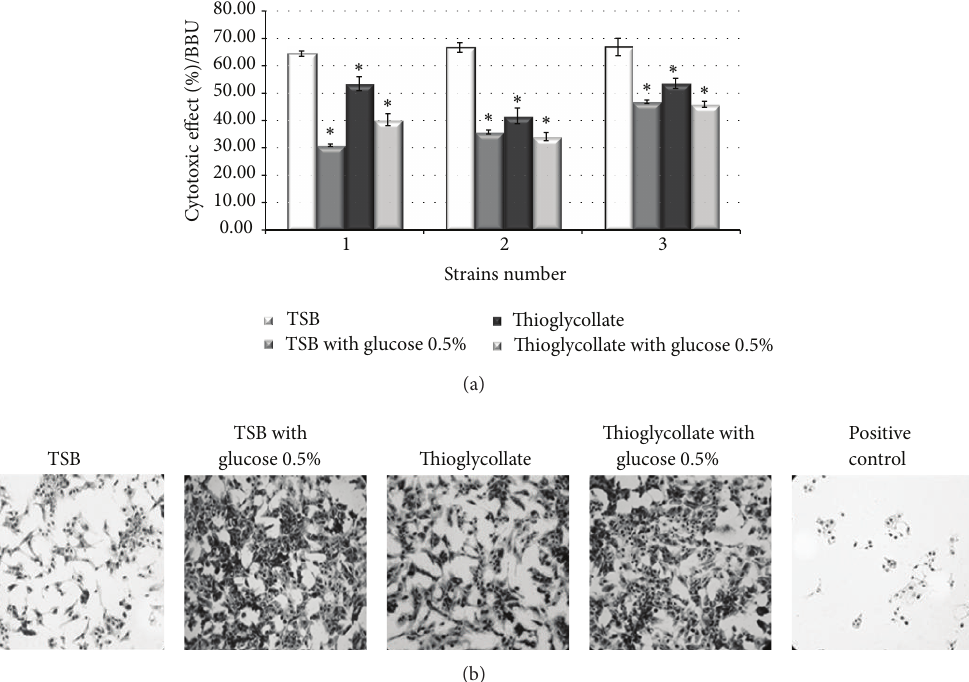
Figure 4: Vero cell cytotoxicity assay. (a) The percent specific cytotoxicity was determined by microscopic quantification after staining the cells. (b) Micrographs of one representative independent experiment of strain N ∘ 1 are depicted (right). ∗ 𝑃 versus TSB < 0.01 and # 𝑃 versus thioglycollate medium < 0.01 being considered statistically